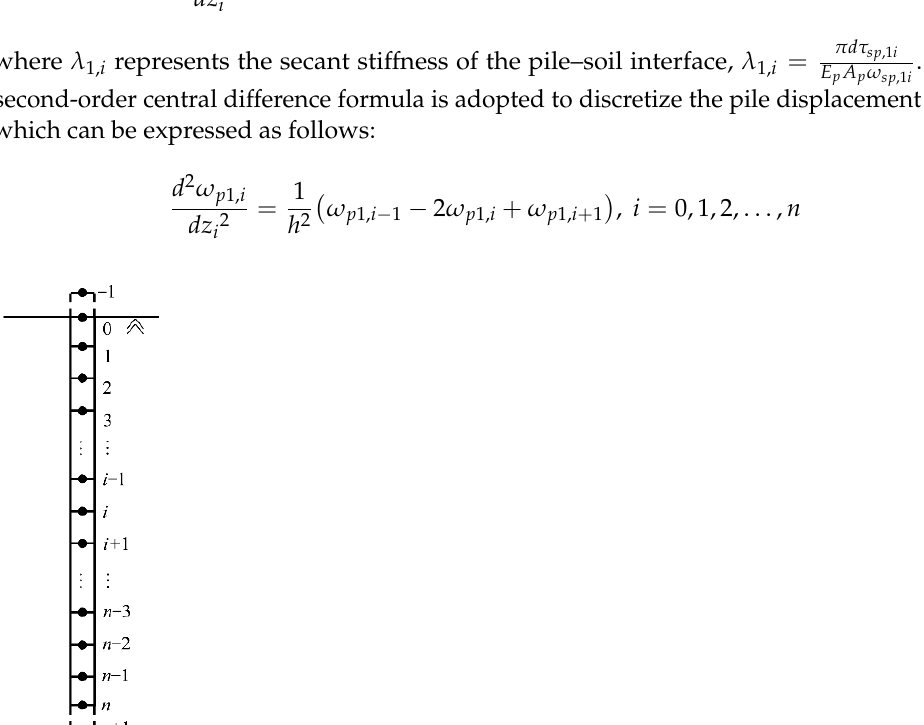
8 of 20 Figure 4. Hyperbolic load-transfer curve for pile shaft during pile loading. The load-transfer curve in the pile loading stage consists of three segments: loading, unloading, and reloading. A piecewise function can describe these segments: